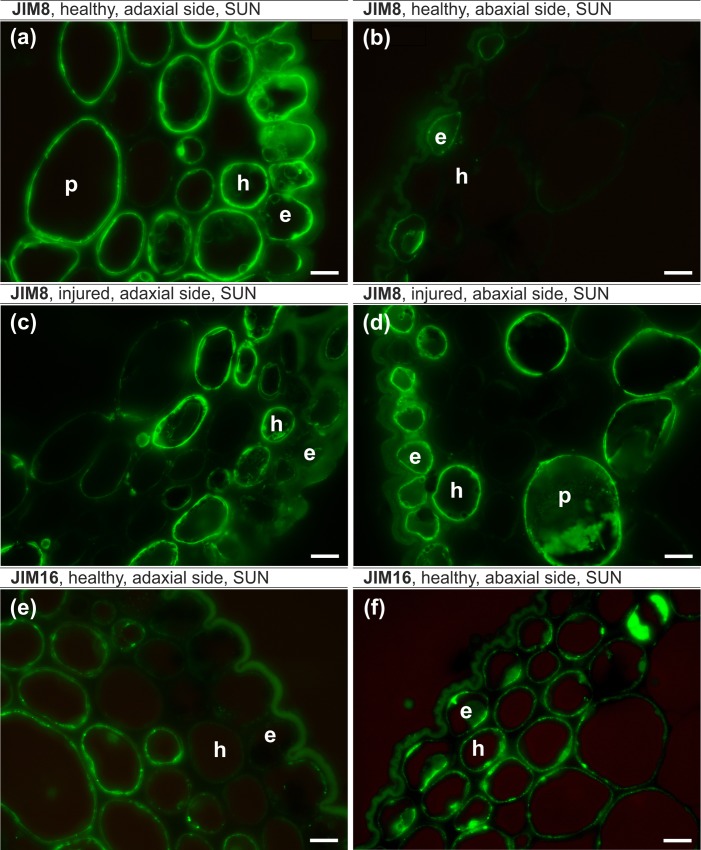
JIM8 epitope (a-d) and JIM16 epitope (e-f) leaf lamina, sunlit side. (a,b,e,f) – healthy leaf, (c,d) – injured leaf, (a,c,e) – adaxial side, (b,d,f) – abaxial side. e – epidermal cells, h – hypodermal cells, p – parenchyma. Bars, 10 μm.